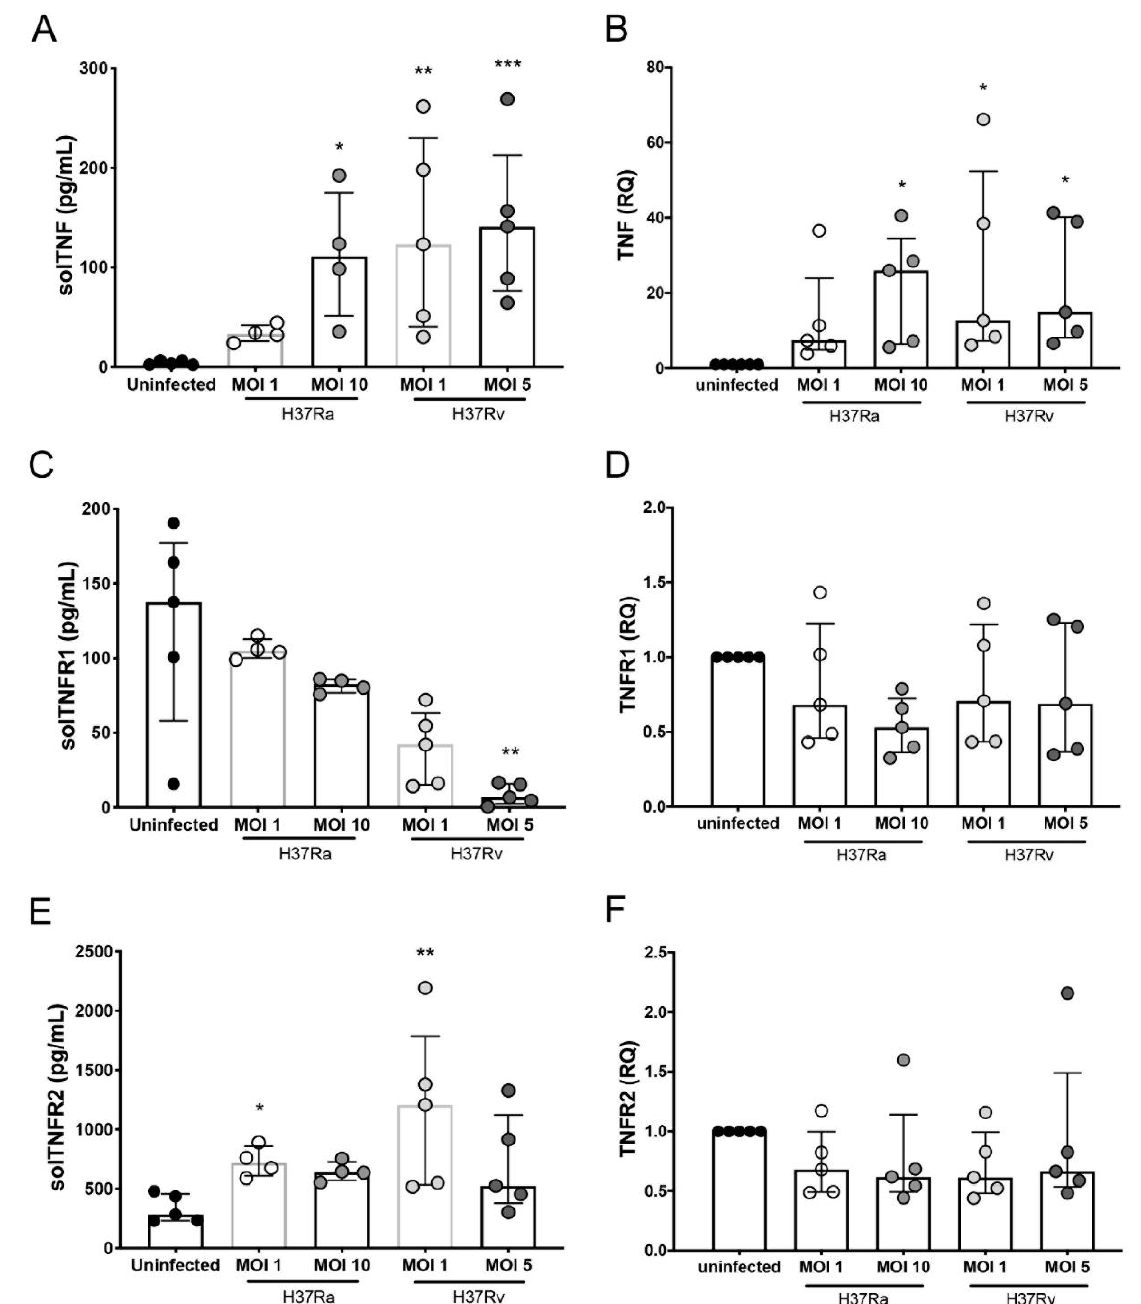
Figure 4. Infection with Mycobacterium tuberculosis (Mtb) H37Rv induces differential expression at the transcript level and the secretion of TNF/TNFR axis molecules in monocyte-derived macrophages (MDMs). Supernatants of MDMs infected with H37Ra (MOI = 1 and 10) and H37Rv (MOI = 1 and 5) Mtb strains at 24 h post-culture (at a ratio of 1 × 10 6 MDMs/mL) were recovered for ELISA,